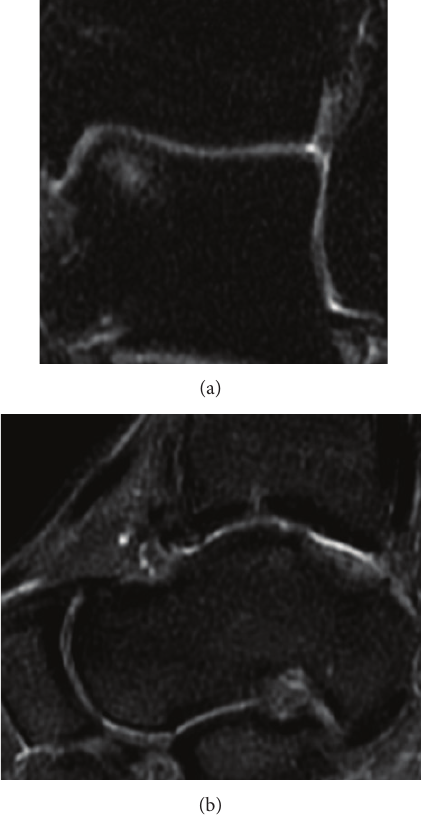
Figure 3: MRI performed 1 year after the second operation, coronal (a) and sagittal (b) views. There are no signs of the previous subchondral cyst. The MOCART scale demonstrates that the defect is completely filled.